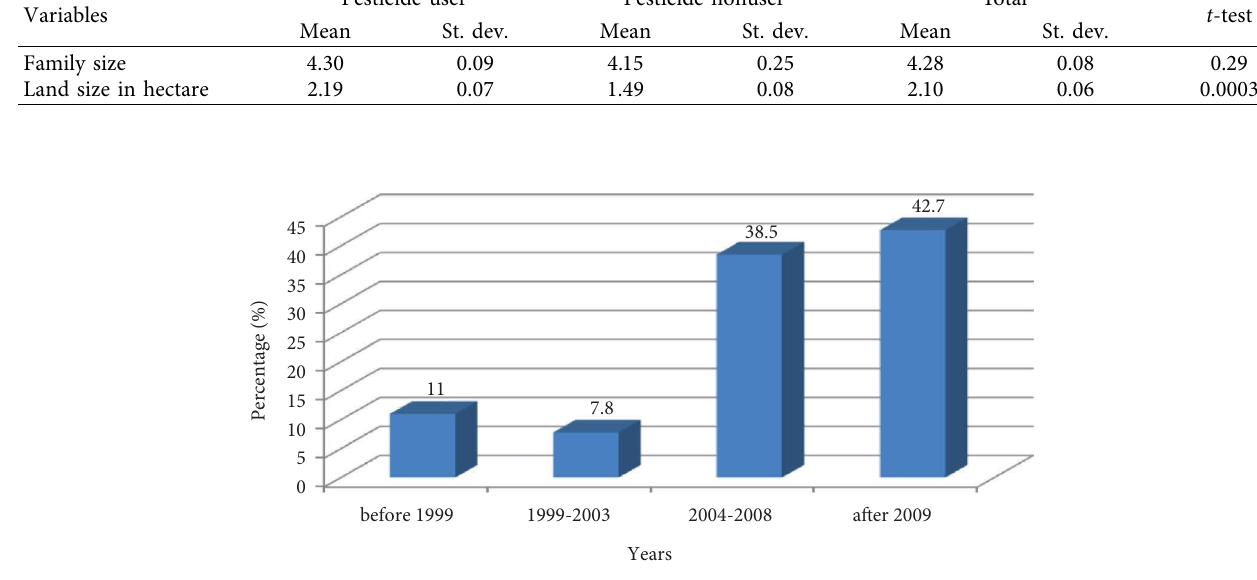
Figure 2: Utilization of pesticides in the study areas according to the respondents. Table 4: Major types of pesticides used by the